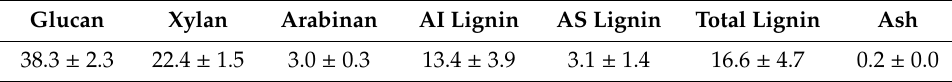
Table 1. Composition of low-moisture anhydrous ammonia (LMAA)-treated SSB (% dry